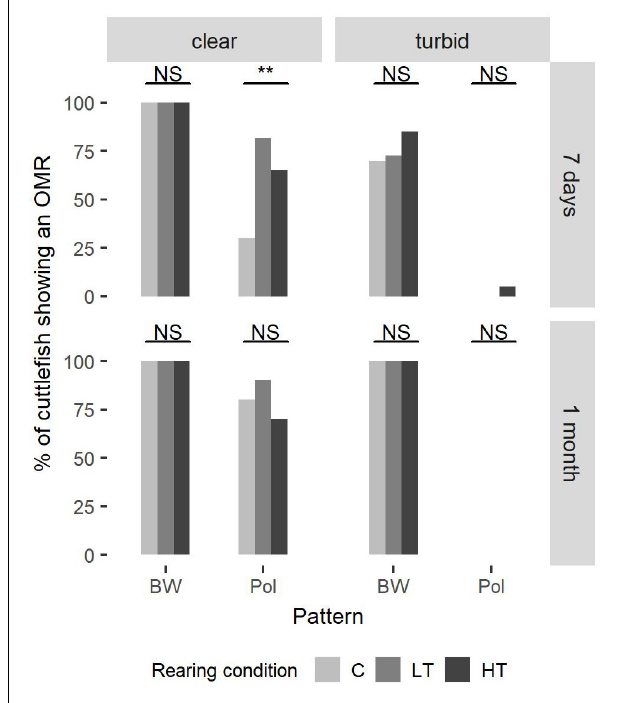
FIGURE 2 | The percentage of cuttlefish showing an optomotor response under three rearing conditions. At 7 days post hatching, 20 cuttlefish were tested in groups C and HT and 22 cuttlefish in group LT. At 1 month post hatching, 10 cuttlefish were tested in each group. Fisher–Freeman–Halton test (Fisher’s exact test for count data with simulated p-value based on 10 5 replicates) was used to compare the three groups, with the addition of a post-hoc pairwise Fisher’s test with Bonferroni corrections. At 7 days in clear water there is significant polarization sensitivity (PS) difference between the groups LT (80%) and C (30%) ( P =